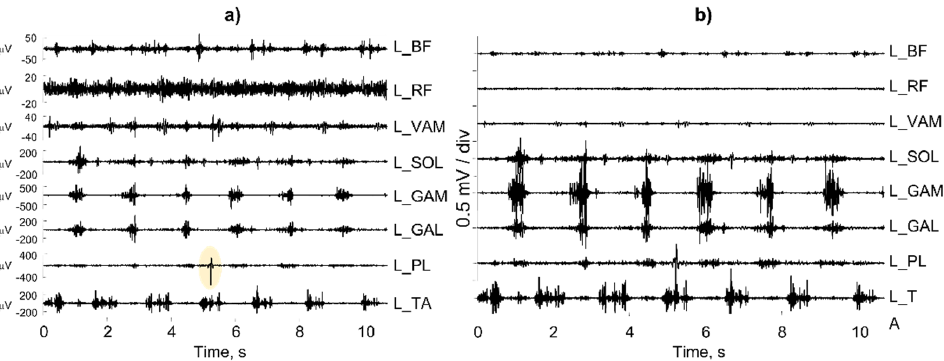
Figure 27. Bipolar sEMG recordings from eight muscles of the left leg during the gait analysis of a subject: ( a ) “autoscale on”; ( b ) same scale for all channels. A superficial visual analysis of ( a ) would lead to incorrect conclusions.